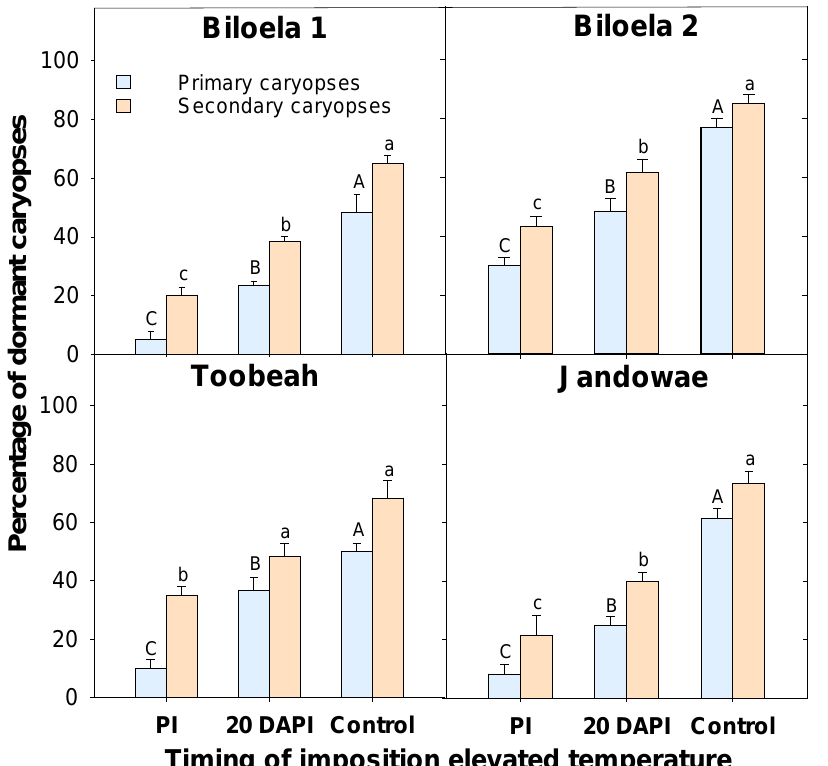
Figure 7. Effect of elevated temperature applied at panicle initiation (PI) or 20 days after panicle initiation (20 DAPI) along with a control (no imposition of elevated temperature) treatment on the dormancy (%) of the freshly harvested primary and secondary caryopses (palea and lemma removed) of four Avena sterilis ssp. ludoviciana biotypes. Error bars represent standard errors of the mean of six replicates of 20 caryopses and represent pooled data from two experimental runs. Letters within a biotype indicate significant differences among the treatments (Bonferroni test). Upper- and lower-case letters are used for primary and secondary caryopses, respectively.